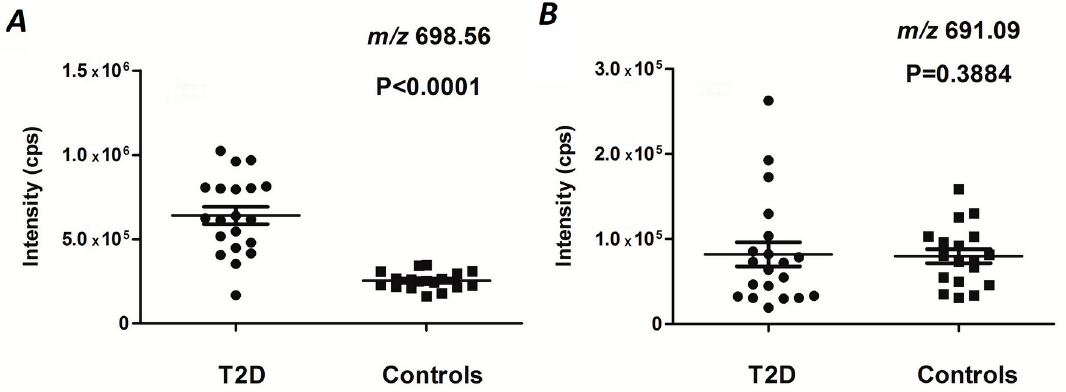
Figure 6. Peak areas of the signals at 38.7 min ( A ), and 48.9 min ( B ), integrated in the extracted ion chromatograms (XICs) of m / z 698.56 ± 0.02 ( A ) and 691.09 ± 0.02 ( B ), corresponding to the [M + 4H] 4 + ions of glycated peptides LVNEVTEFAK Am TCCAMVADESAENCCAMDK (human serum albumin, A ) and QNCCAMELFEQLGEYK Am FQNALLVR (human serum albumin, B ), respectively. The data